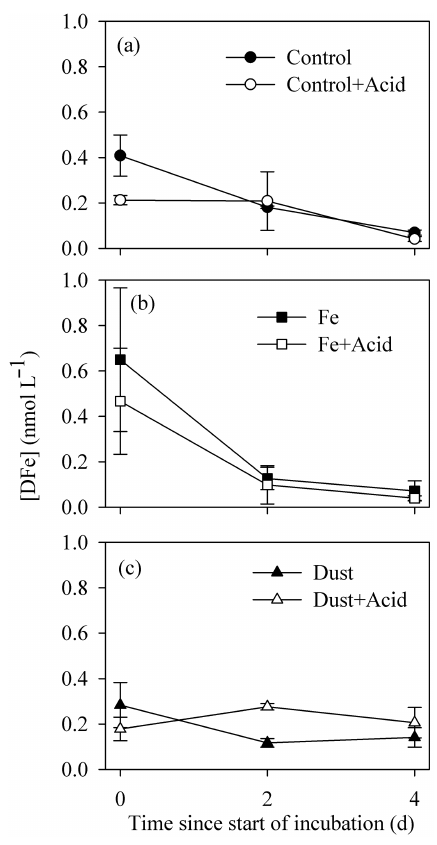
Figure 1. Average concentration of DFe in each treatment during the incubations measured at T0, T2, and T4. Panel (a) : Control and Control + Acid. Panel (b) : Fe and Fe + Acid. Panel (c) : Dust and Dust + Acid. Error bars indicate standard deviations. n = 3 except for Acid, T0, T2, Dust + Acid, T0, and Control (all times), where n = 2.